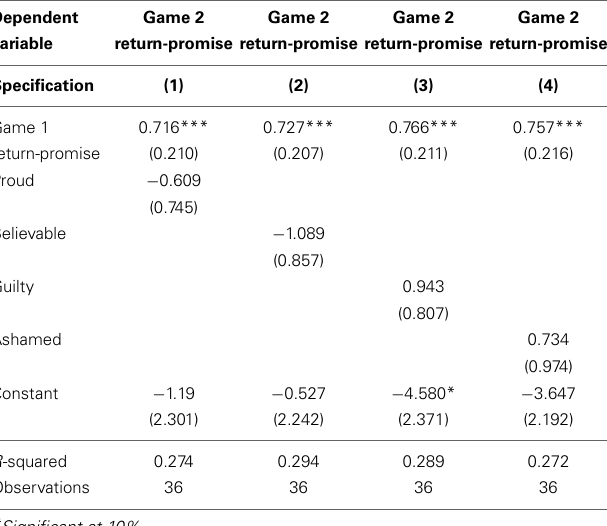
Table 9A | Regression of game 2 Signal Value on promise breaking trustees’ emotions.